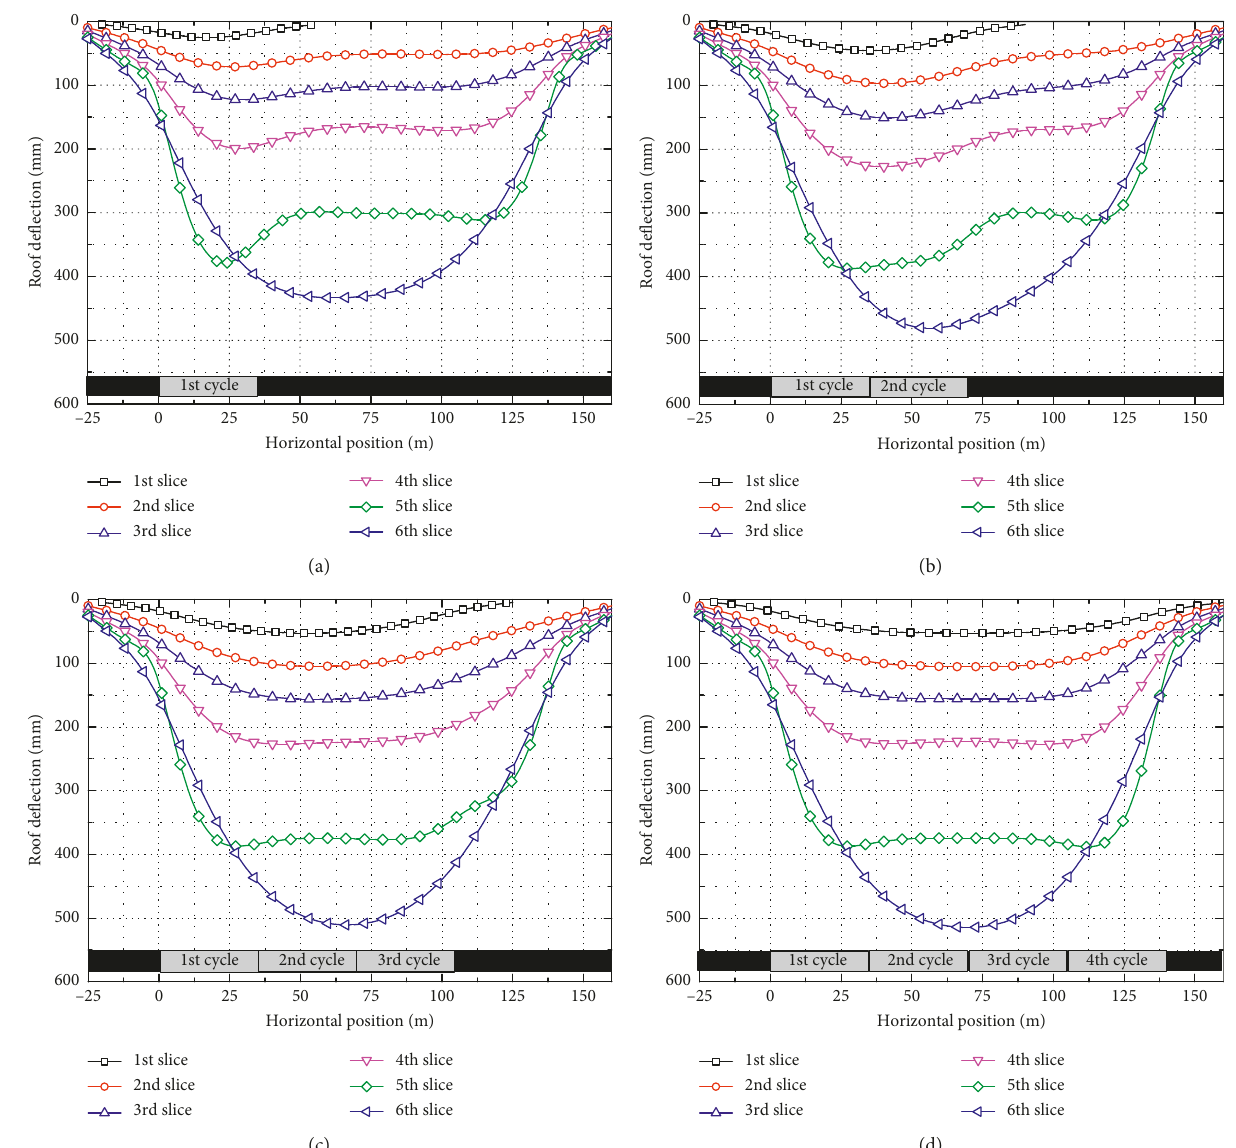
Figure 9: Deflection curves of the roof in different cycles during mining each slice: (a) first mining cycle; (b) second mining cycle; (c) third mining cycle; (d) fourth mining cycle. Table 2: Allowable tensile stress and bending moment of the roof for different slices. Slice